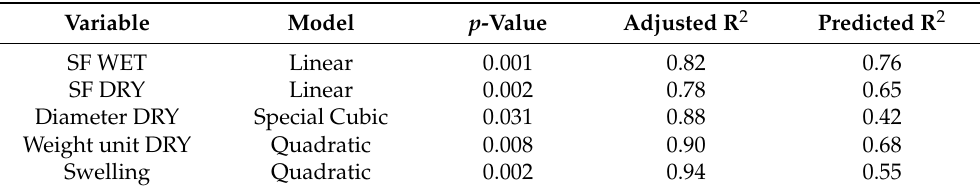
Table 3. Summary of significative mathematical